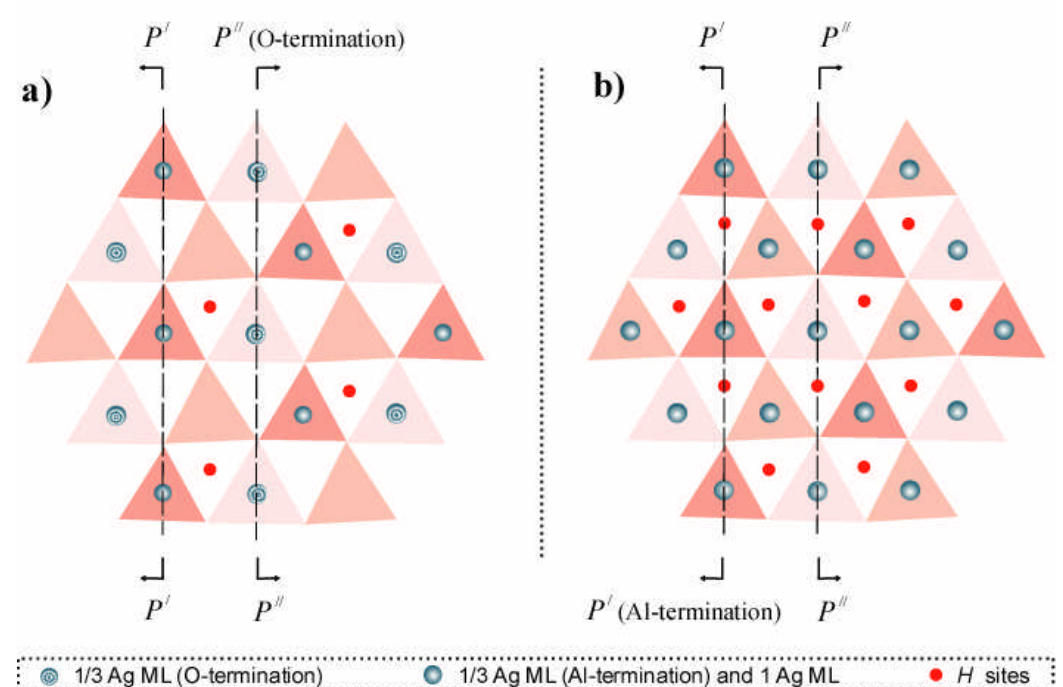
Figure 3 . Top views of Ag atom distributions over Al- and O-terminated corundum (0001) surfaces for the two different coverages: 1/3 ML of the Ag(111) plane (a) and 1 Ag ML (b). The two different silver atom adsorption positions are above equilateral and versatile triangles forming the outermost O plane. Circles with two different internal patterns (a) show the two kinds of Ag atom distributions over equilateral triangles on Al- and O-terminated substrates, whereas positions over versatile triangles are shown by red dots in both (a) and (b). Planes P ¢- P ¢ and P ¢¢- P ¢¢ are used in Figs. 4 and 5, respectively, to show the electron charge density distributions in cross sections perpendicular to the (0001)